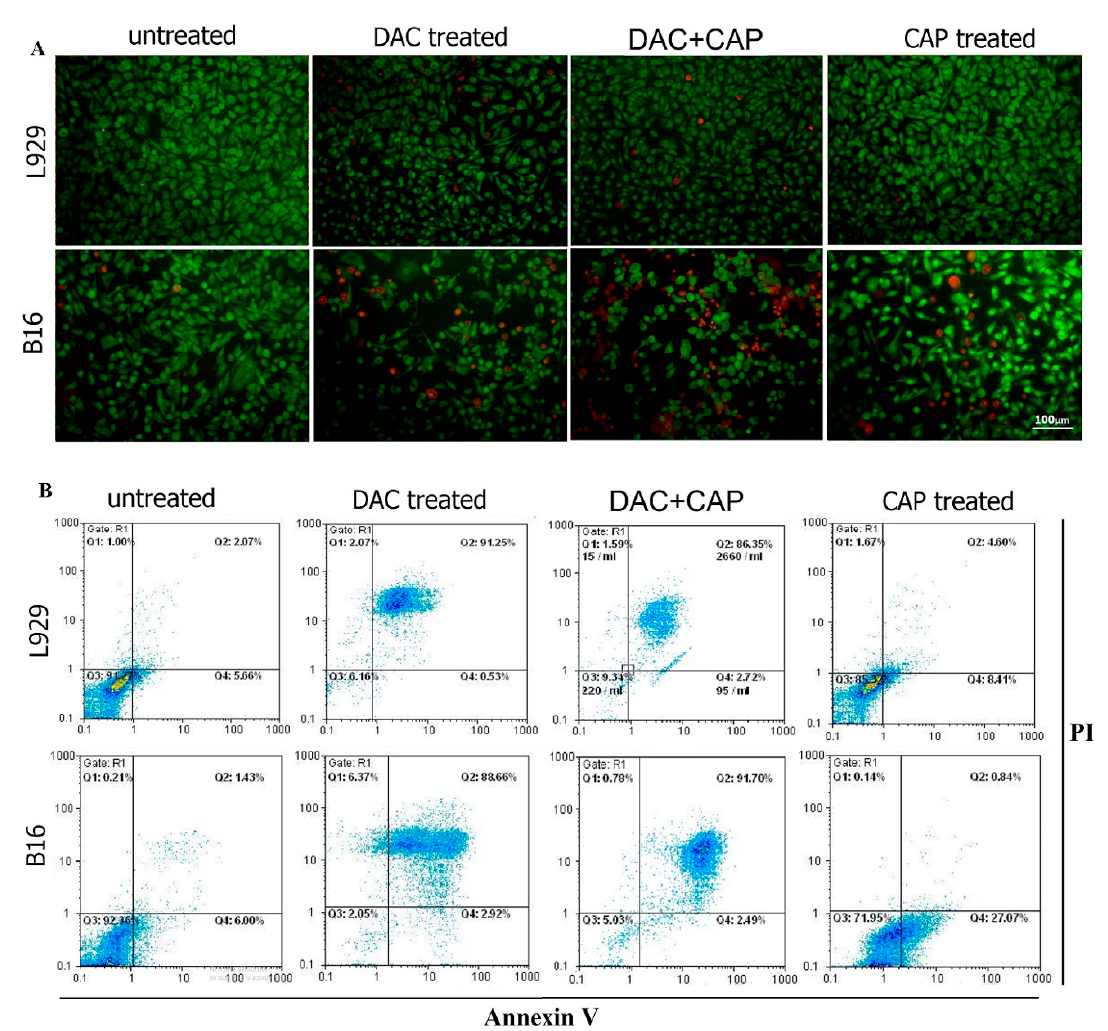
Figure 4. Effect of CAP and DAC on apoptosis.The pattern of AO/EB staining in B16 tumor cells or non-malignant L929 cells treated with CAP (45-sec exposure) or DAC (100 µg/mL), or without any treatment (untreated). ( A ) Green fluorescence shows the live cells, while orange fluorescence represents the dead cells. Annexin V/PI flow cytometry analysis of the B16 and L929 cells 24 h post the different treatment regimens. The data represent the percentage of live cells (Q3), early (Q4) or late (Q2) apoptotic cells, and necrotic cells (Q1). ( B ) Data are representative of three independent experiments. The scale bar is 100 µm.